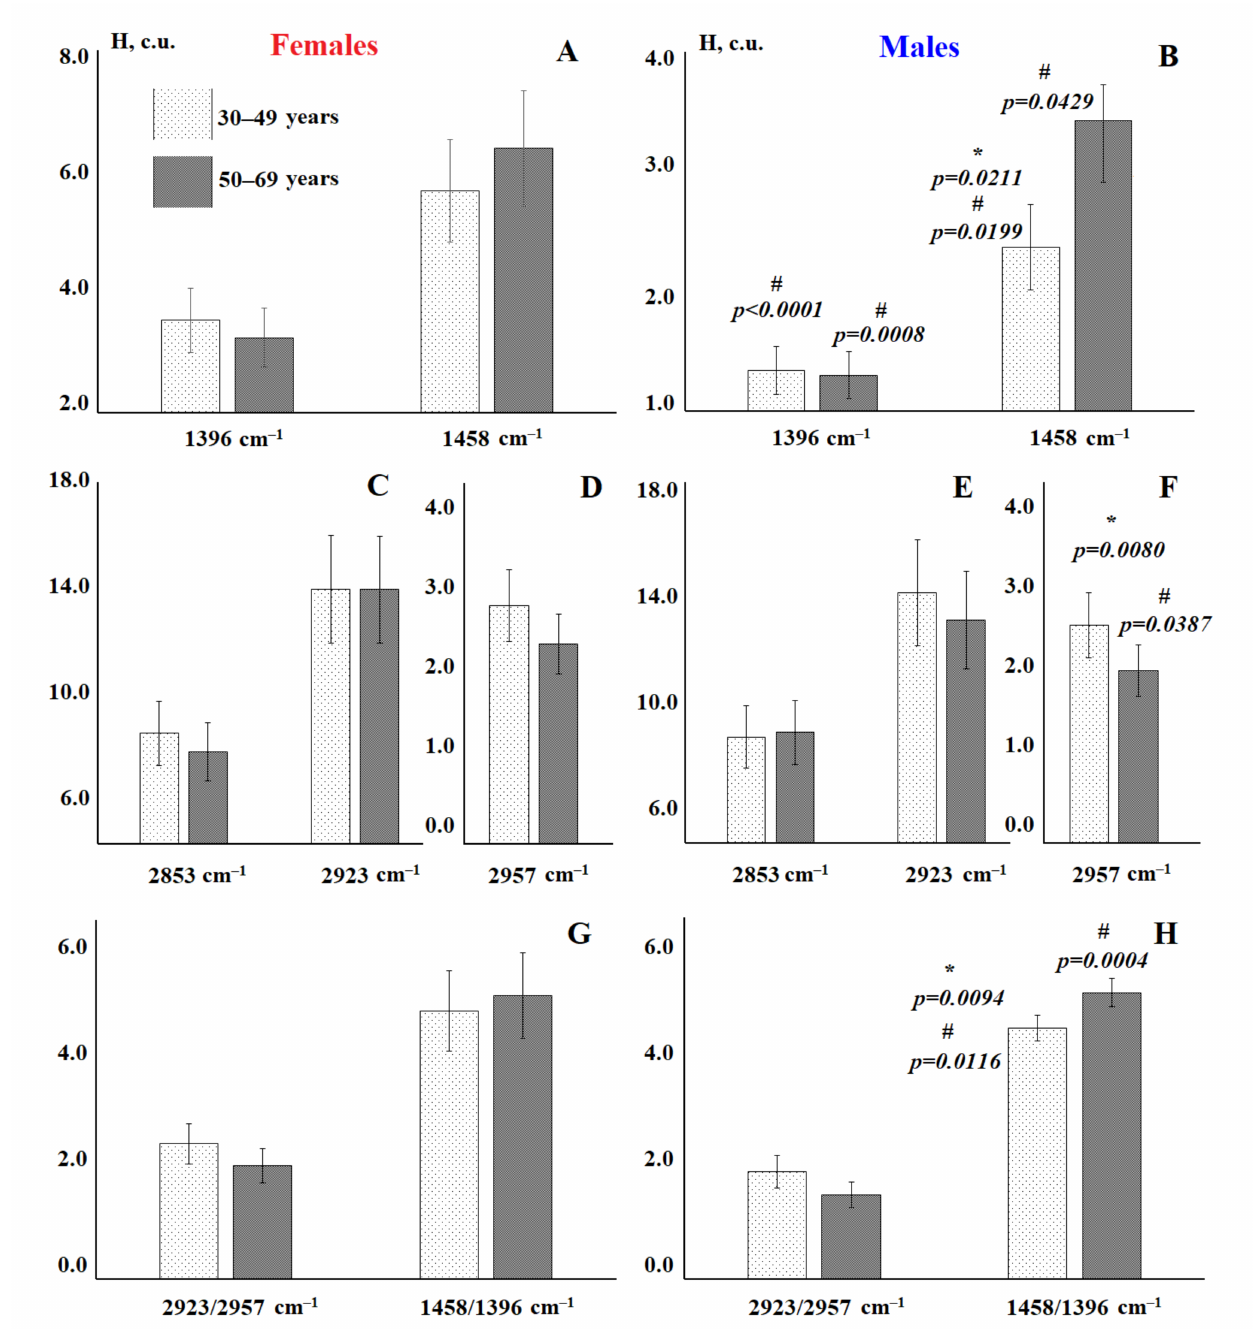
Figure 3. Intensity of lipid absorption bands in the IR spectra of saliva of males and females of the control group depending on age: absorption bands at 1396 and 1458 cm − 1 ( A , B ), 2583 and 2923 cm − 1 ( C , E ), 2957 cm − 1 ( D , F ), ratios 2923/2957 and 1458/1396 cm − 1 ( G , H ). *—differences between different age groups of the same gender are statistically significant, #—differences between volunteers of different gender within one age group are statistically significant, p < 0.05. p -values are calculated using the paired Mann–Whitney